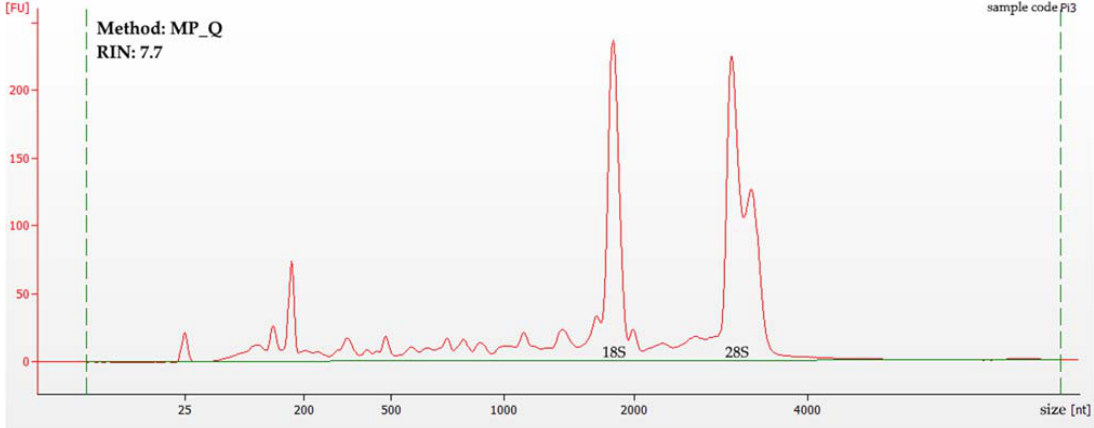
Figure 2. A sample of the 2100 Bioanalyzer data from a 6000 RNA pico chip. The X -axis represents the molecule size in nucleotides, with the Y -axis representing the fluorescence in fluorescence units. The green dotted lines are thresholds. The peaks for 18S and 28S rRNA are marked.